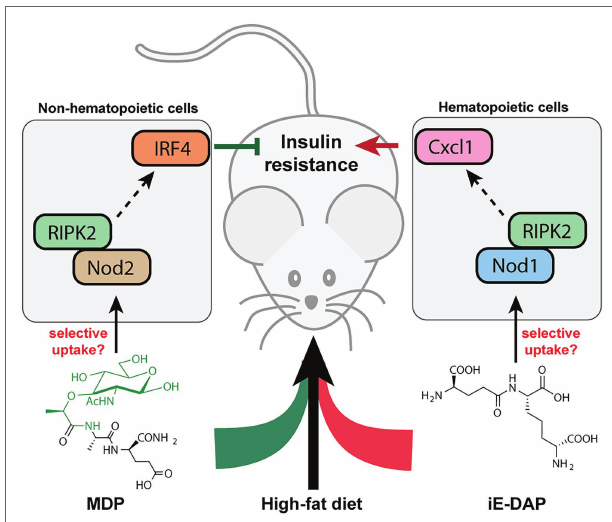
FIGURE 4 | Peptidoglycan fragment agonists of NOD1 and NOD2 pathways manifest opposing effects on insulin resistance in high-fat diet mice. While MDP, a NOD2 ligand that triggers overexpression of IRF4 via PIPK2 in non- hematopoietic cells, ameliorates insulin resistance induced by high-fat diet in mice, the iE-DAP agonist of NOD1 pathways induces Cxcl1 expression via RIPK2 in hematopoietic cells that contributes to insulin resistance in high-fat diet